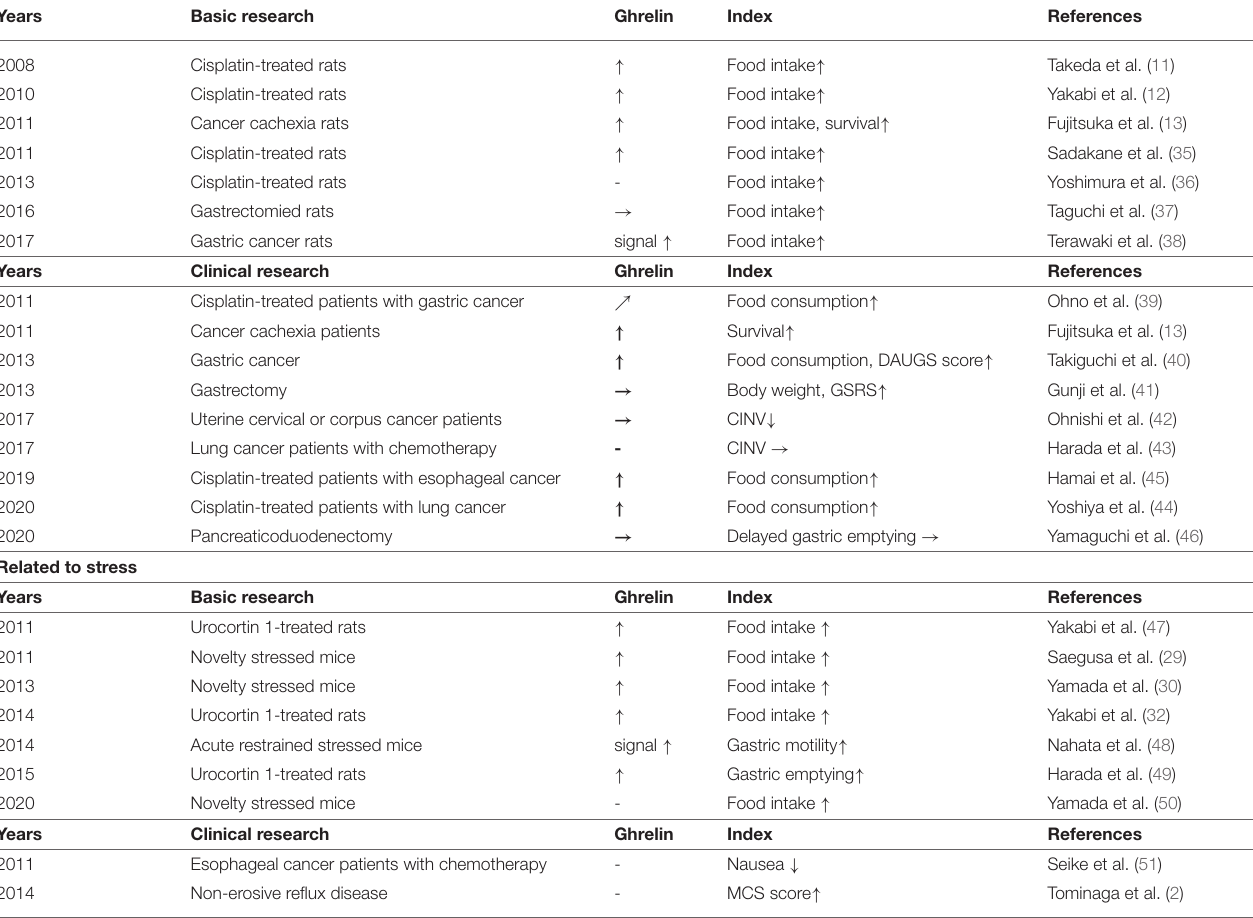
TABLE 1 | The effect of rikkunshito on the main evaluation and on ghrelin in each study.